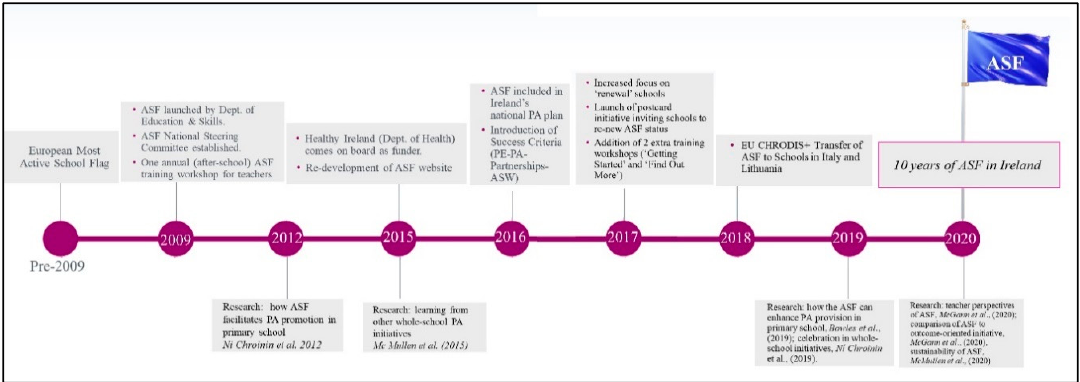
Figure 1. Active School Flag timeline.